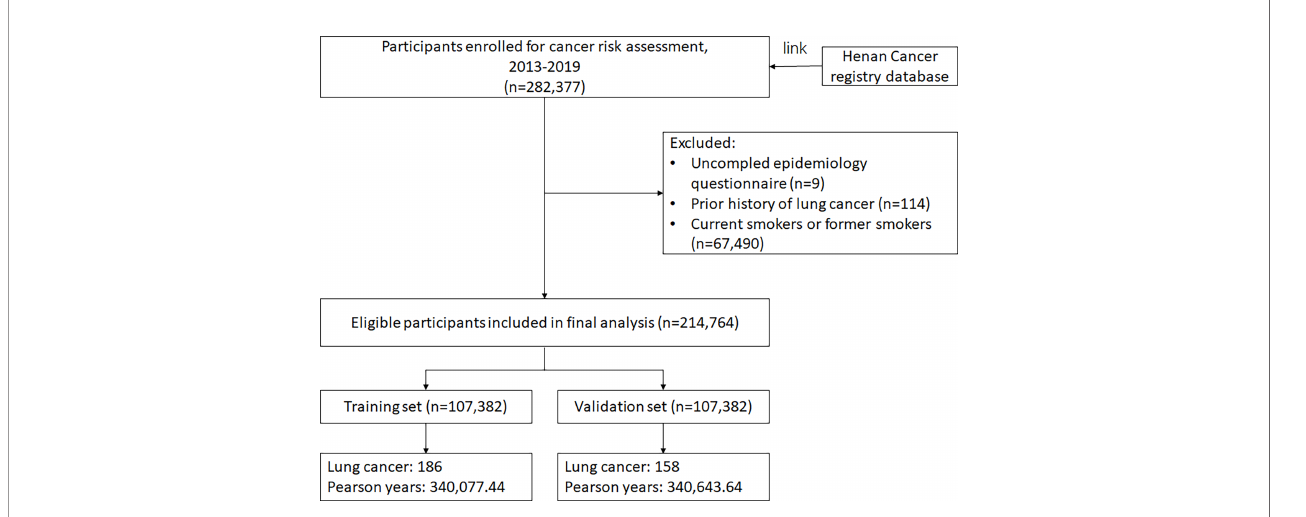
FIGURE 1 | Flow chart of participants included in this